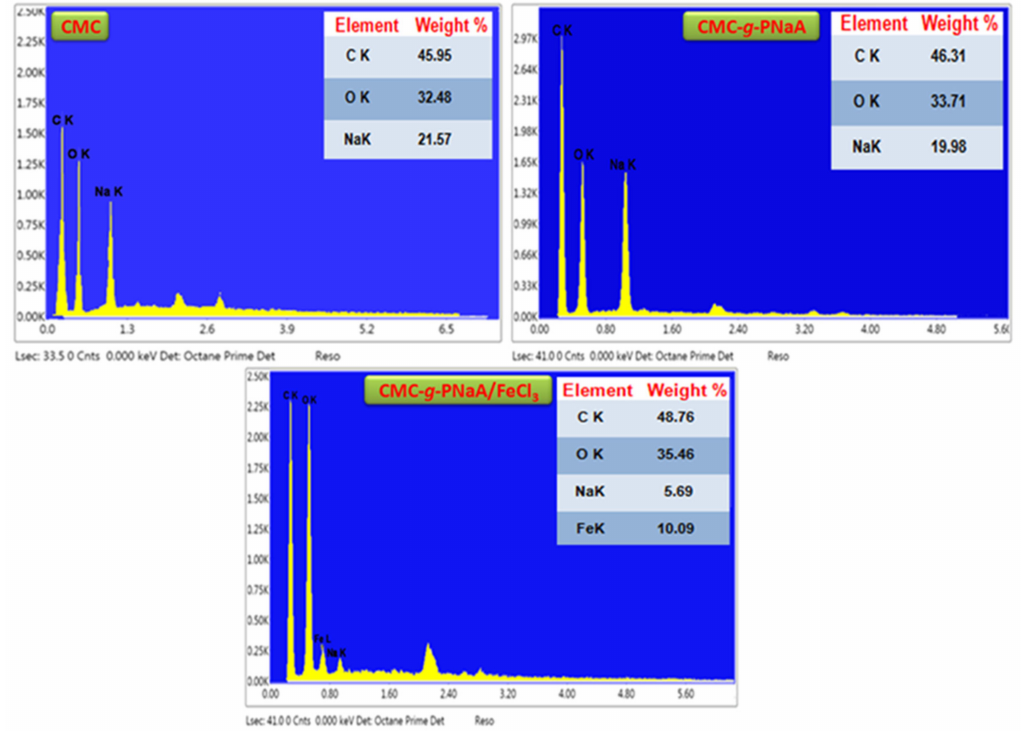
Figure 3. Energy dispersive X-ray analysis (EDX) spectra of CMC, CMC- g -PNaA and CMC- g - PNaA / FeCl 3 hydrogel beads.